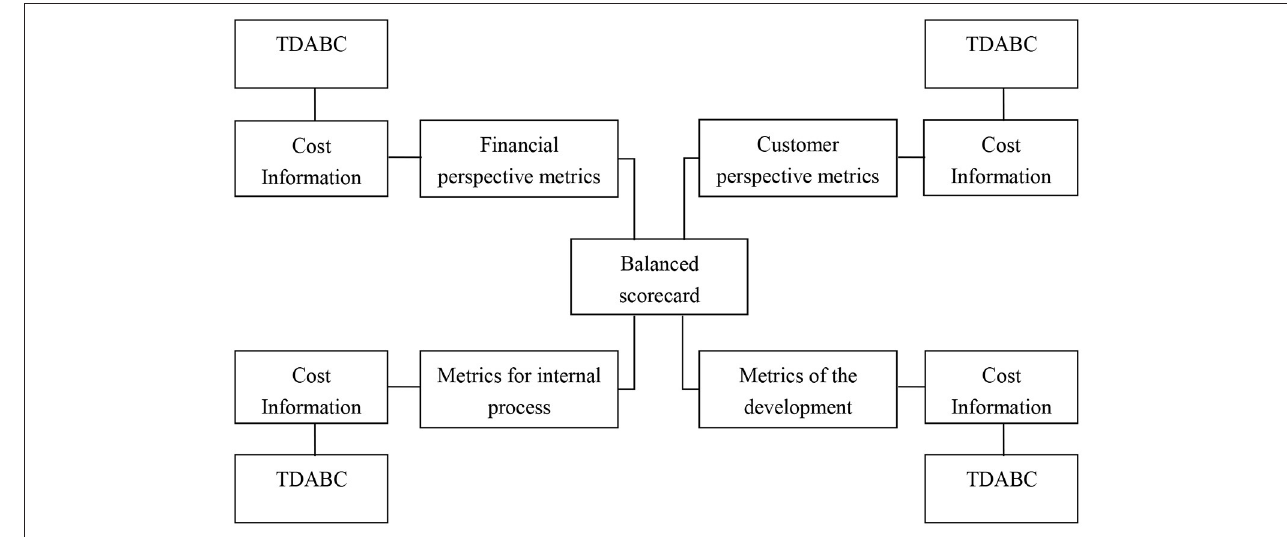
FIGURE 3 | Combining balanced scorecard with TDABC.